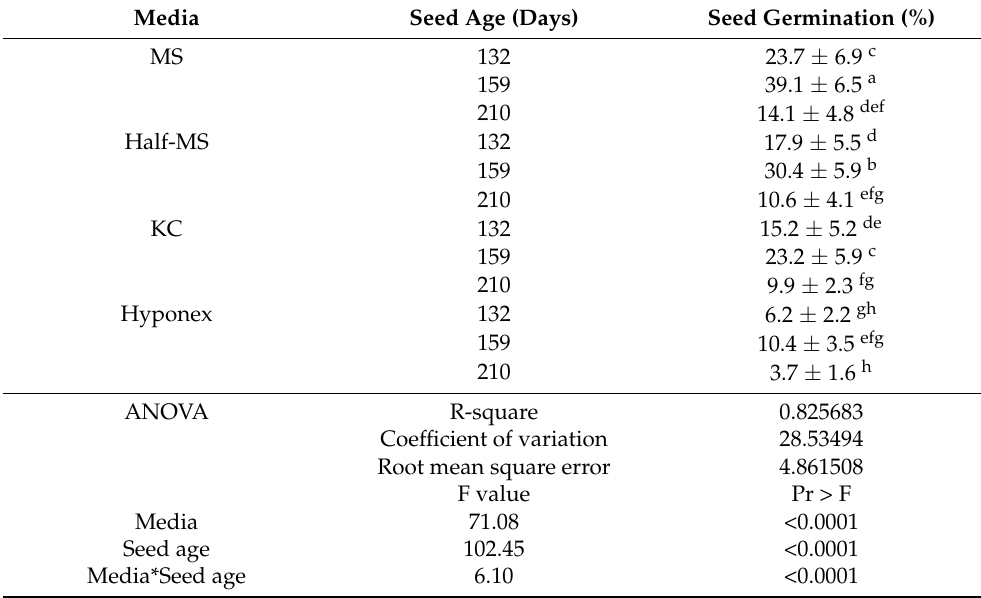
Figure 1. In vitro asymbiotic SLC seed germination: ( a ) Seeds extracted from SLC capsules were placed on culture media (0-day); ( b ) Light micrograph of SLC seeds (10-day); ( c ) Induction of protocorms (90-day); ( d ) Light micrograph of protocorm formation (60-day). Scale bar. ( a , c ) 10 mm; ( b , d ) 0.1 mm. Table 1. Effect of media and seed age on seed